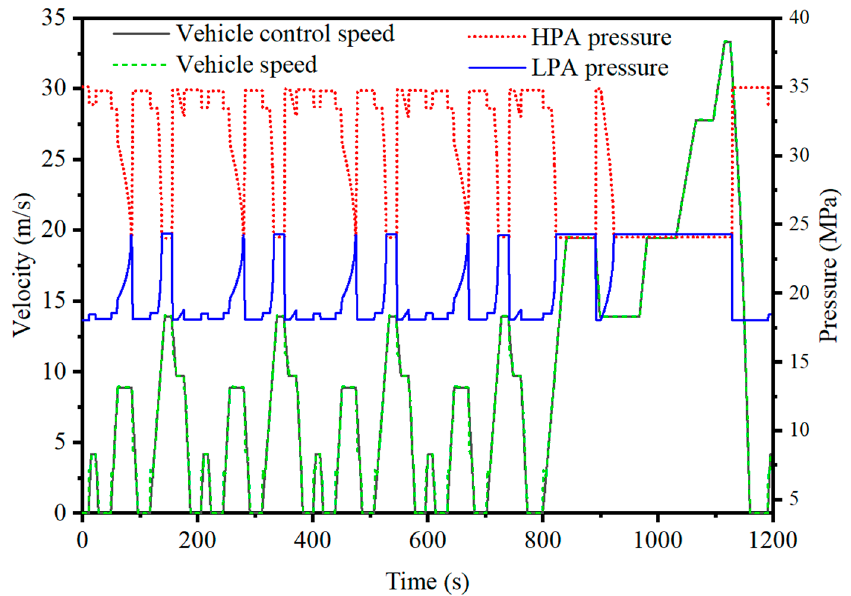
Figure 15. Diagram of the speed and pressure curves .